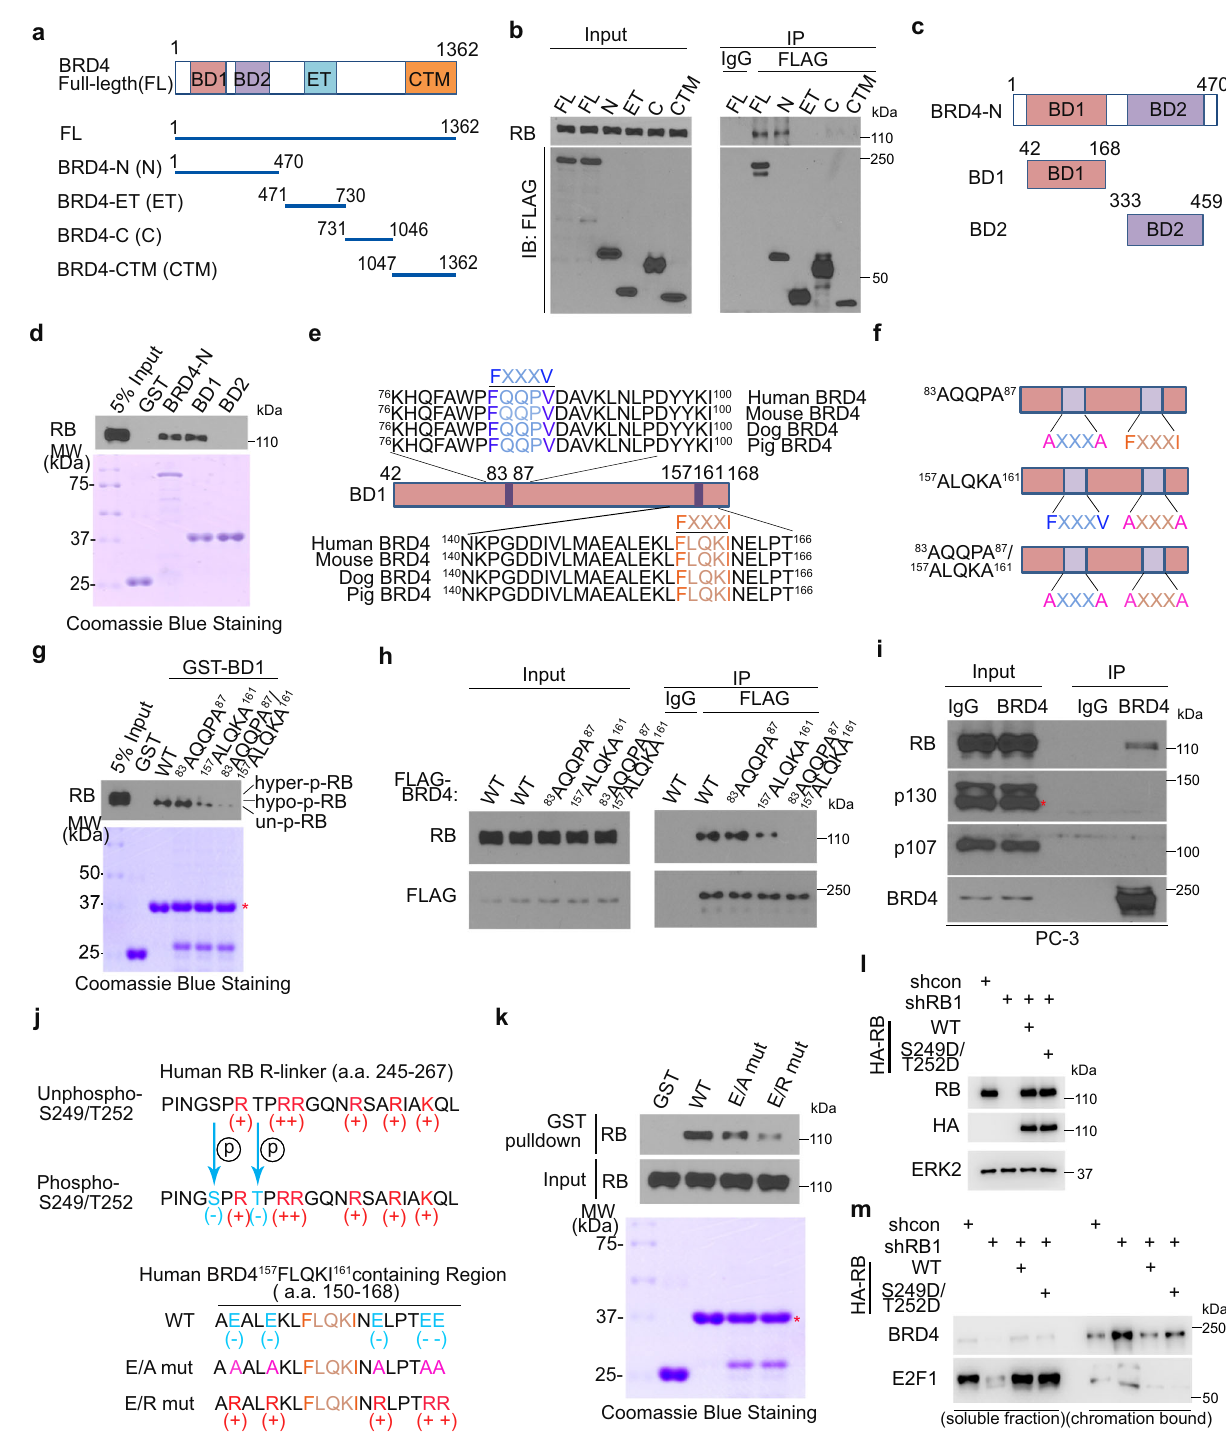
Fig. 3 | BRD4 interacts with RB through an FXXXI motif in the BD1 domain. a Diagramshowingdifferentmammalianexpressionvectorsforfull-length(FL)and truncated BRD4 proteins. b WB analysis of RB protein in input and co-IP samples from C4-2 cells transfected with different fragments of BRD4. c Diagram showing GST-BRD4 recombinant proteins containing two or each single BD domain. d Top, WBanalysisofRBproteinsfromC4-2celllysatepulleddownbydifferentGST-RB-N recombinant proteins. Bottom, Coomassie blue staining of GST and GST-RB-N recombinantproteins. e DiagramshowingthelocationofFXXXVandFXXXImotifs in BD1 of BRD4. f Diagram showing single or double mutants of FXXXV and FXXXI motifs. g Top, WB analysis of RB proteins from C4-2 cell lysate pulled down by different GST-BD1 and mutant recombinant proteins. Bottom, Coomassie blue stainingofGSTandGST-BD1andmutantrecombinantproteins. h WBanalysisofRB